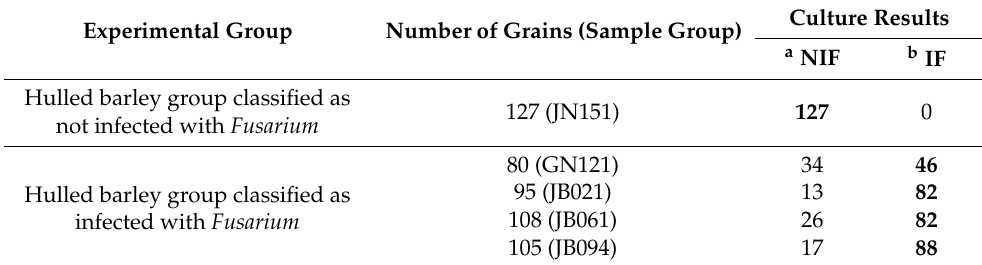
Figure 6. Culture results for hulled barley (GN121, JB021, JB061, JB094) in the experimental group in which Fusarium was observed. Table 4. Culture results for control group and experimental group of hulled barley samples infected with Fusarium .